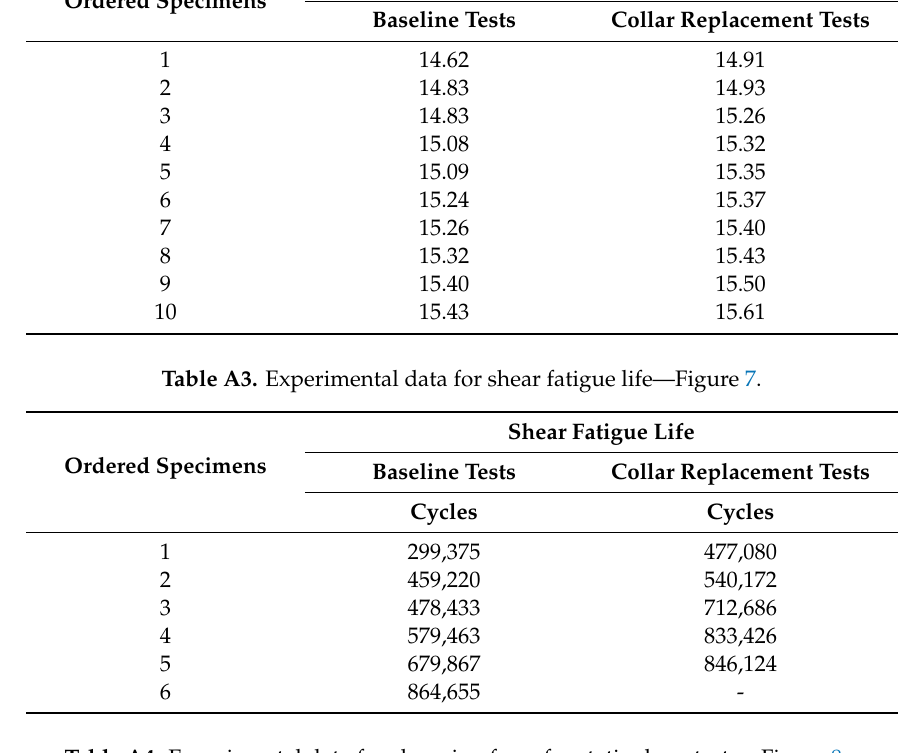
Table A4. Experimental data for clamping force for static shear tests—Figure 8a.